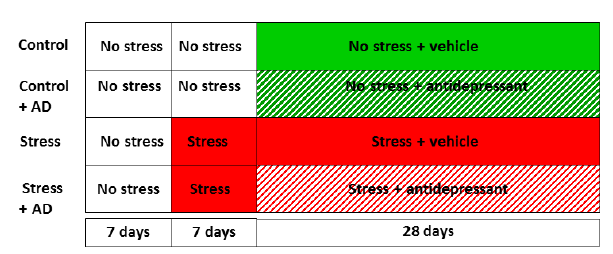
Figure 6. Schematic presentation of the experimental design of an- tidepressant drug studies. Control: no stress; AD: